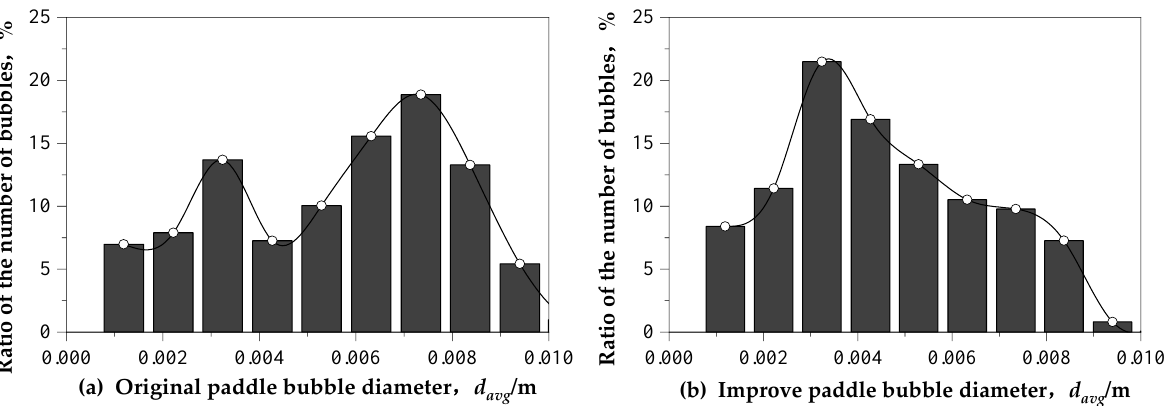
Figure 8. Gas distribution under different impeller type combinations under 125 rpm.